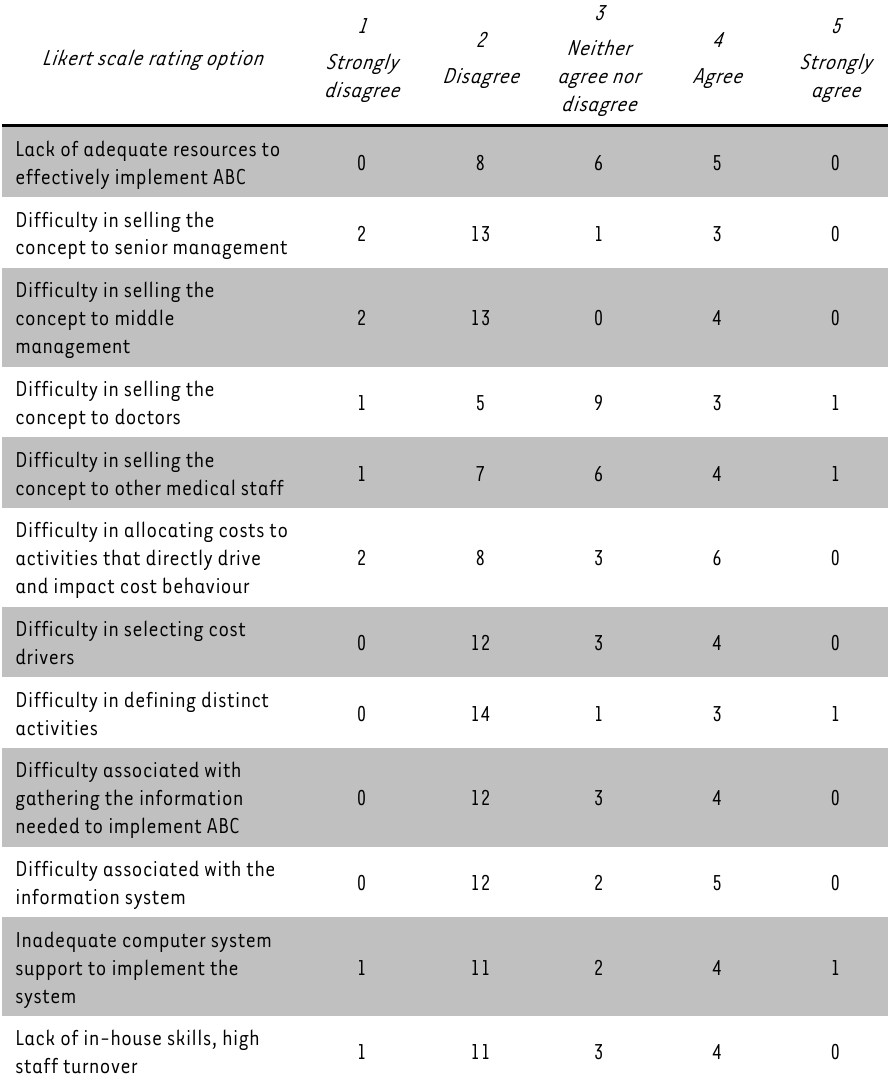
TABLE 3: Problems experienced in the adoption ABC